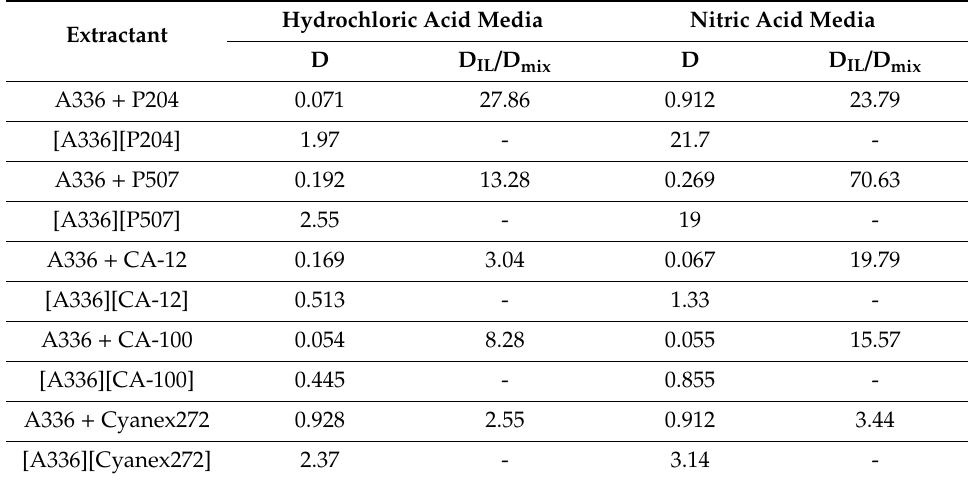
Table 6. Comparison of the distribution ratios obtained using mixed extractants and Bi-ILs in hydrochloric acid and nitric acid media [154]; published by Elsevier, 2010.